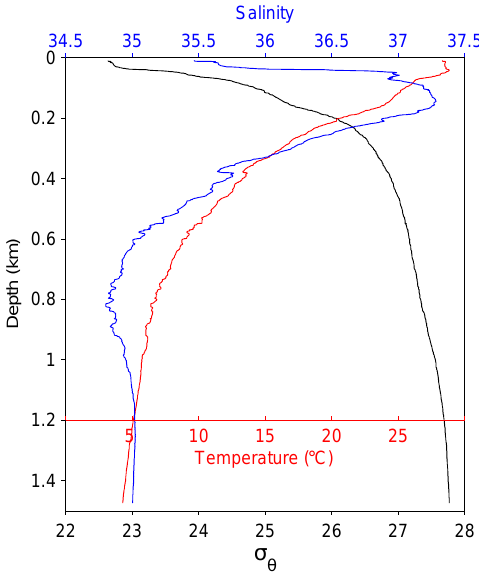
Fig. 3. Temperature (red), salinity (blue) and potential density anomaly ( σ θ , referenced to zero pressure, black) measured by HRP dive 125 near the eastern end of the seismic profile (Fig. 1). Water masses characteristic of this region are the Caribbean Surface Water with a salinity less than 35.5 at depths less than 50m, Subtropical Underwater at depths 50–200m and a salinity maximum exceeding 37, and Antarctic Intermediate Water at depths 600–1000m and a salinity minimum of around